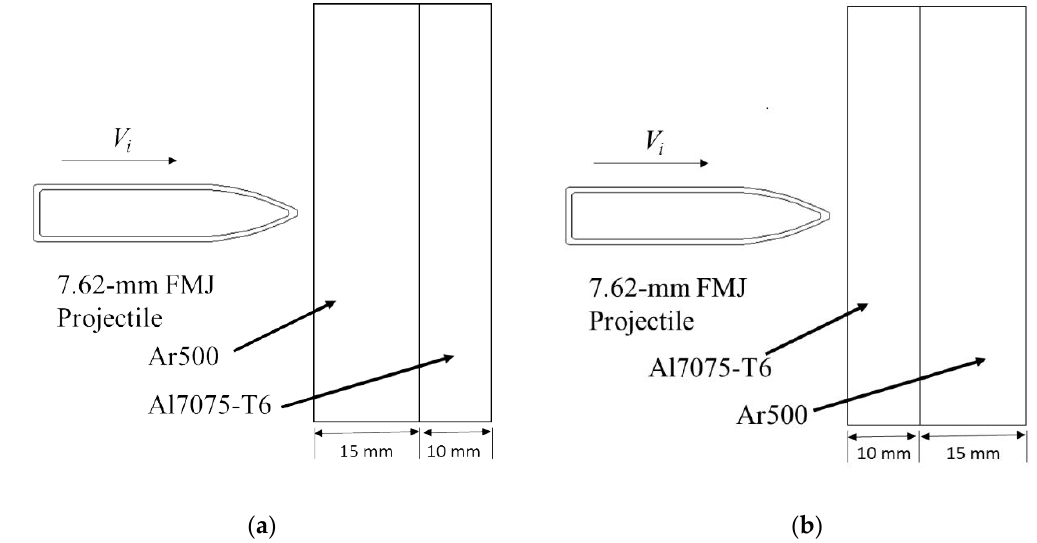
Figure 4. The cross-section geometrical model of the 7.62-mm FMJ projectile double-layered panel for: ( a ) Configuration A; and ( b ) Configuration B.